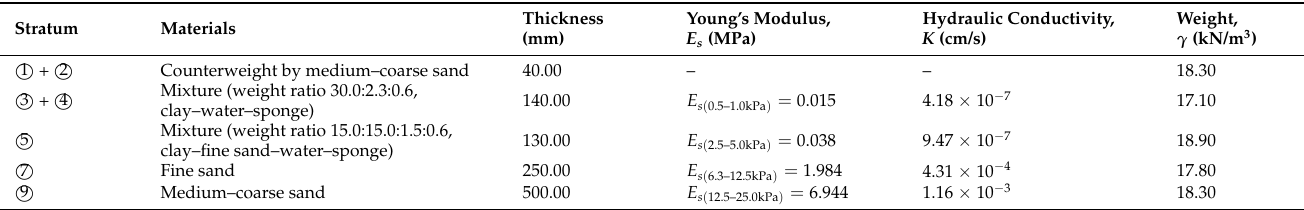
Table 3. Parameters of similar materials.